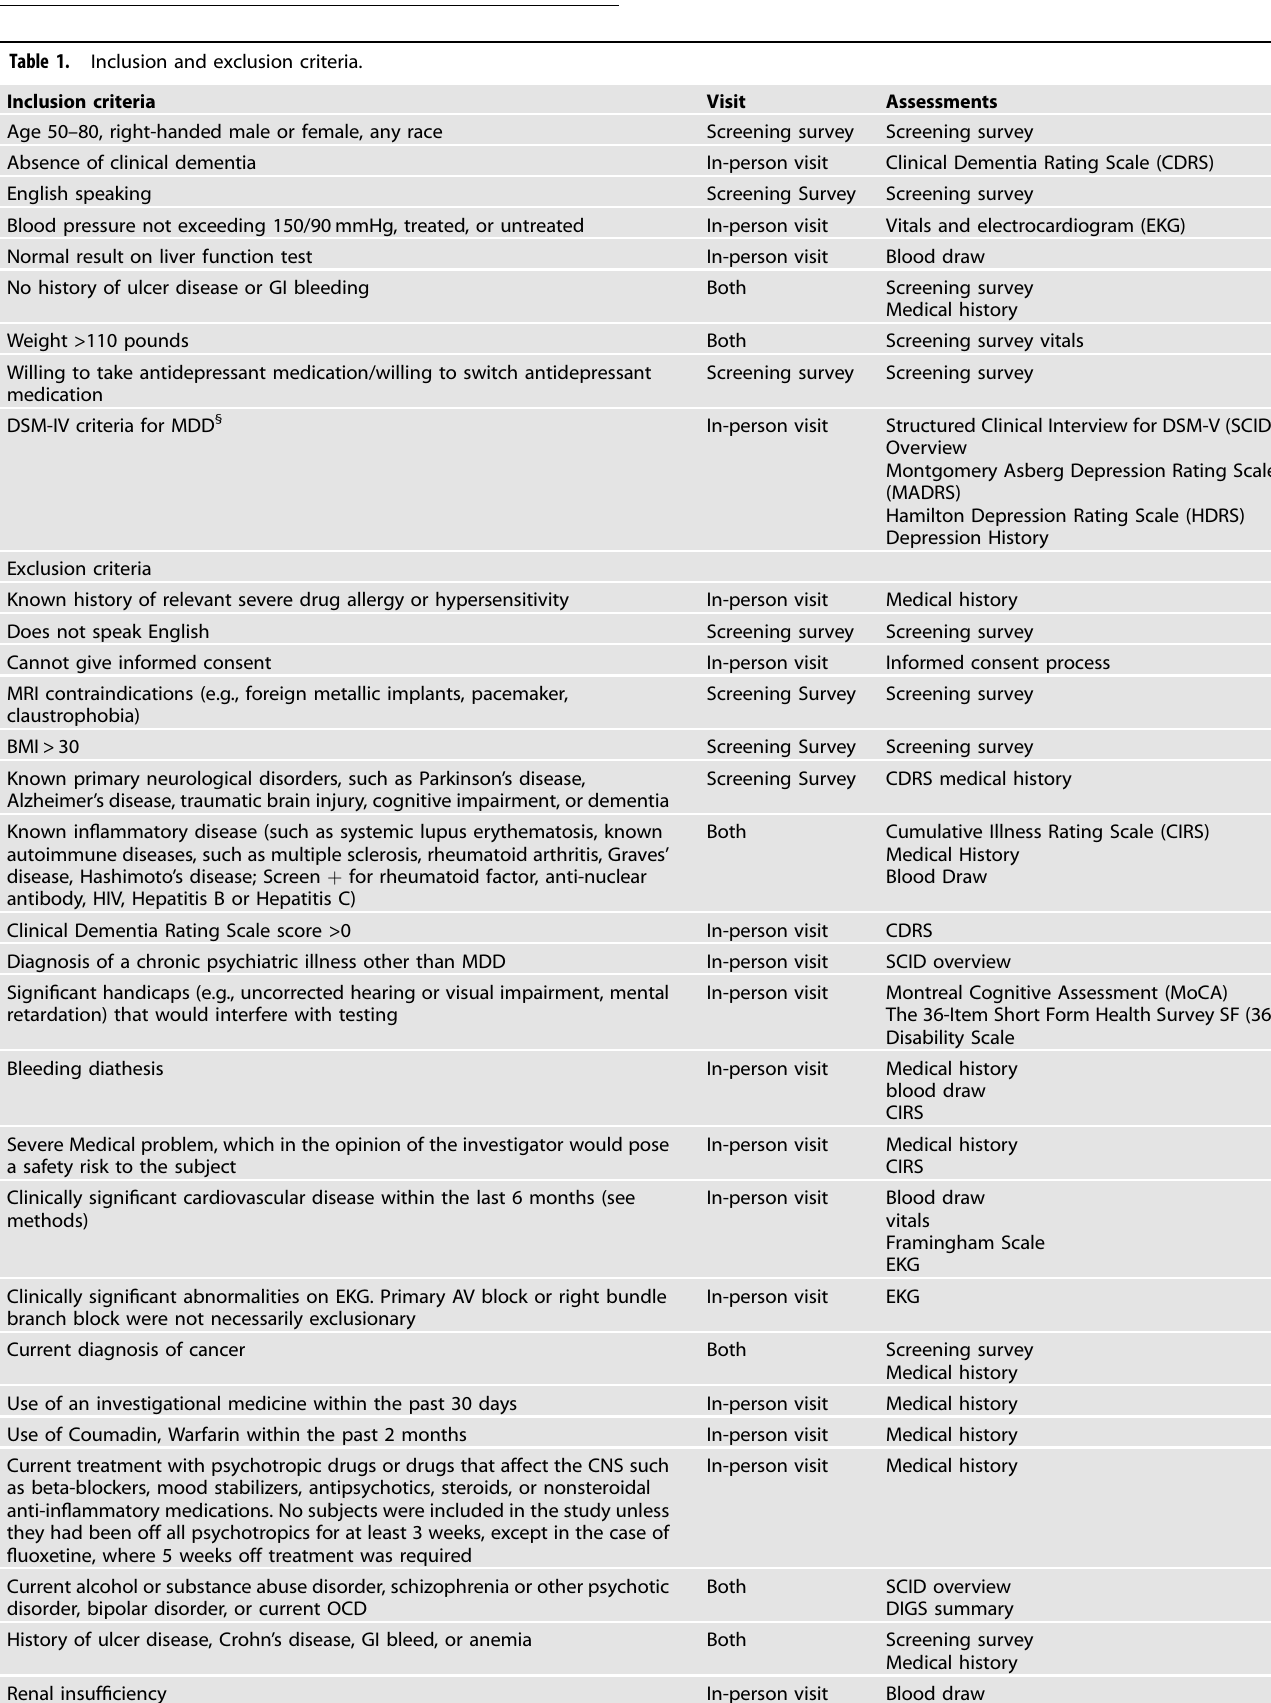
Table 1. Inclusion and exclusion